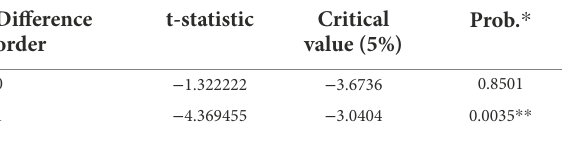
TABLE 1 Ln(c) ADF Test Results. Difference